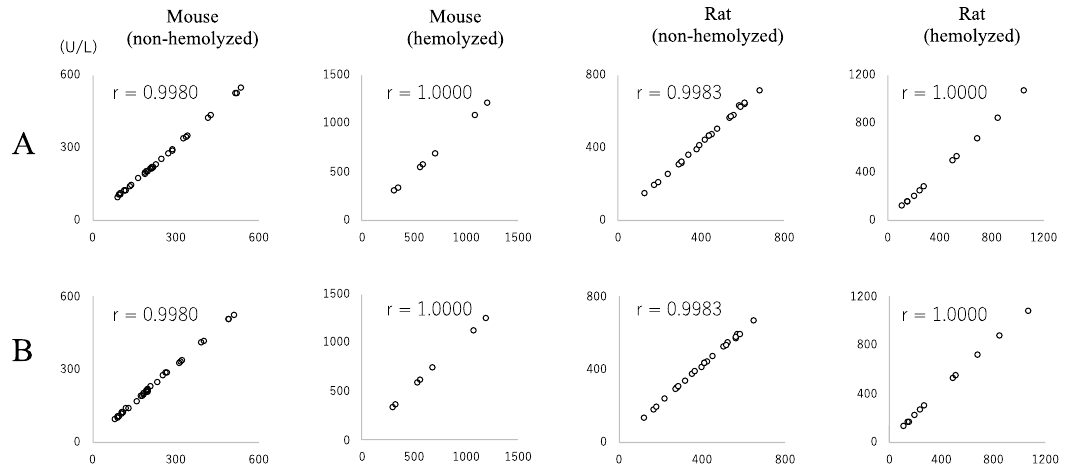
Figure 6. Scatter plots of the measured LD values (x-axis) and estimated LD values (y-axis) using the conversion factors. ( A ): Measured IFCC LD values (x) and estimated IFCC LD values (y) obtained from the JSCC values using the conversion factors. ( B ): Measured JSCC LD values (x) and estimated JSCC LD values (y) obtained from the IFCC values using the conversion factors.